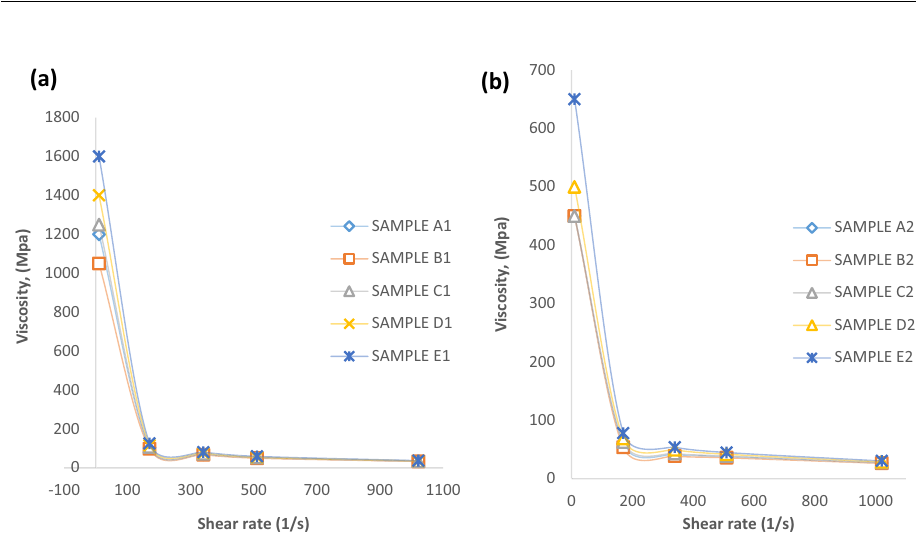
Fig. 2 The mud systems shear thinning characteristics for a aqueous and b non-aqueous drilling